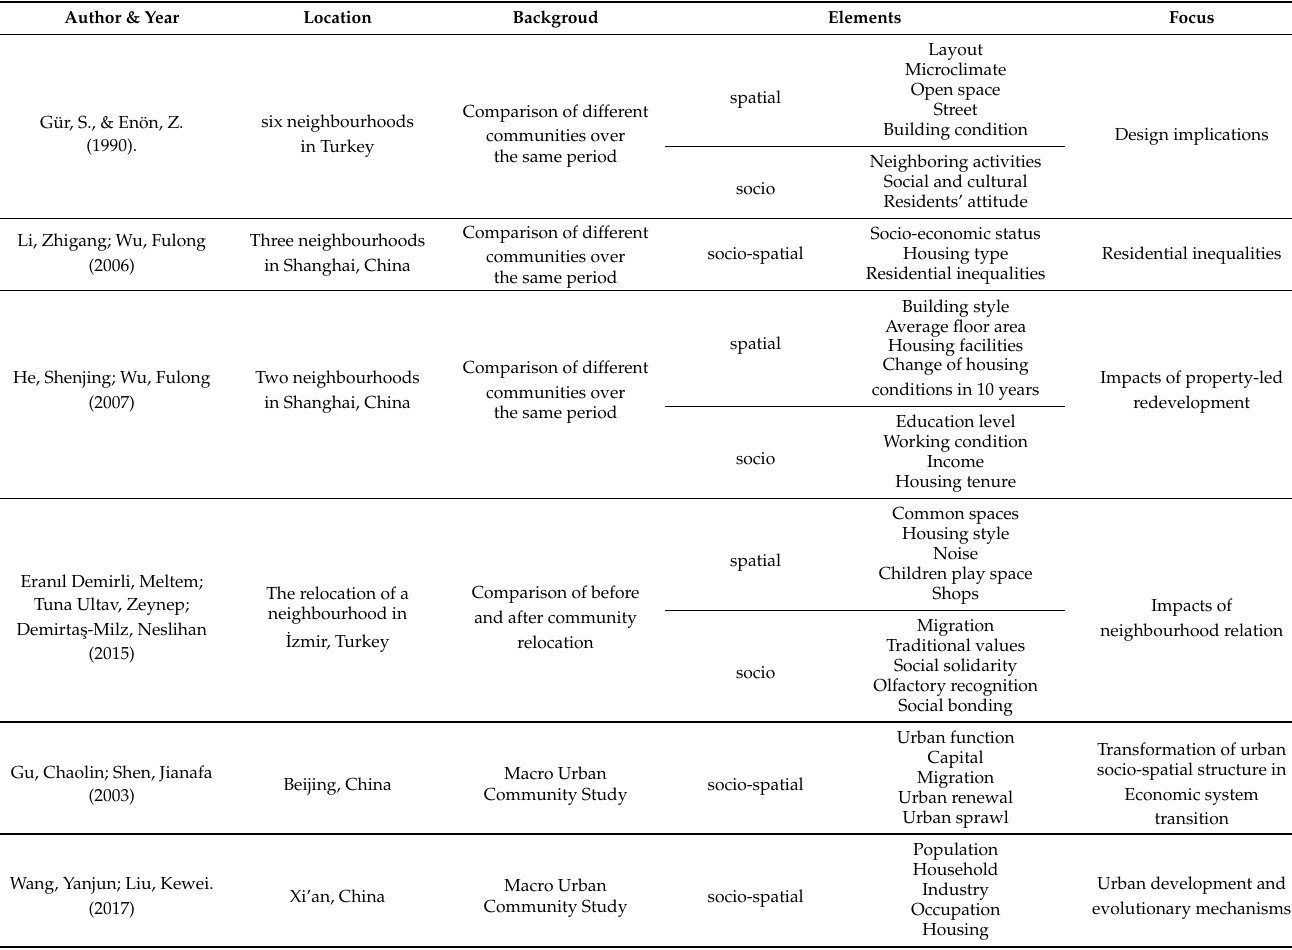
Table 1. Neighbourhood studies using a socio-spatial